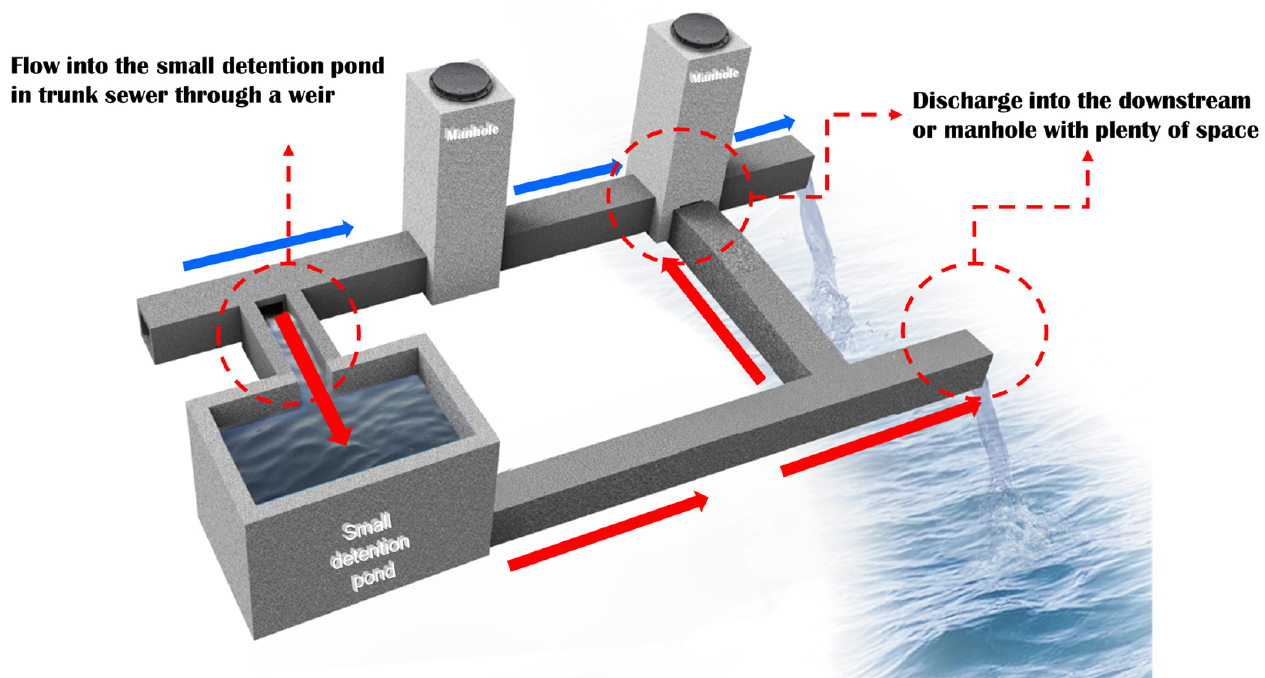
Figure 1. Schematic of the trunk drainage sewer system.